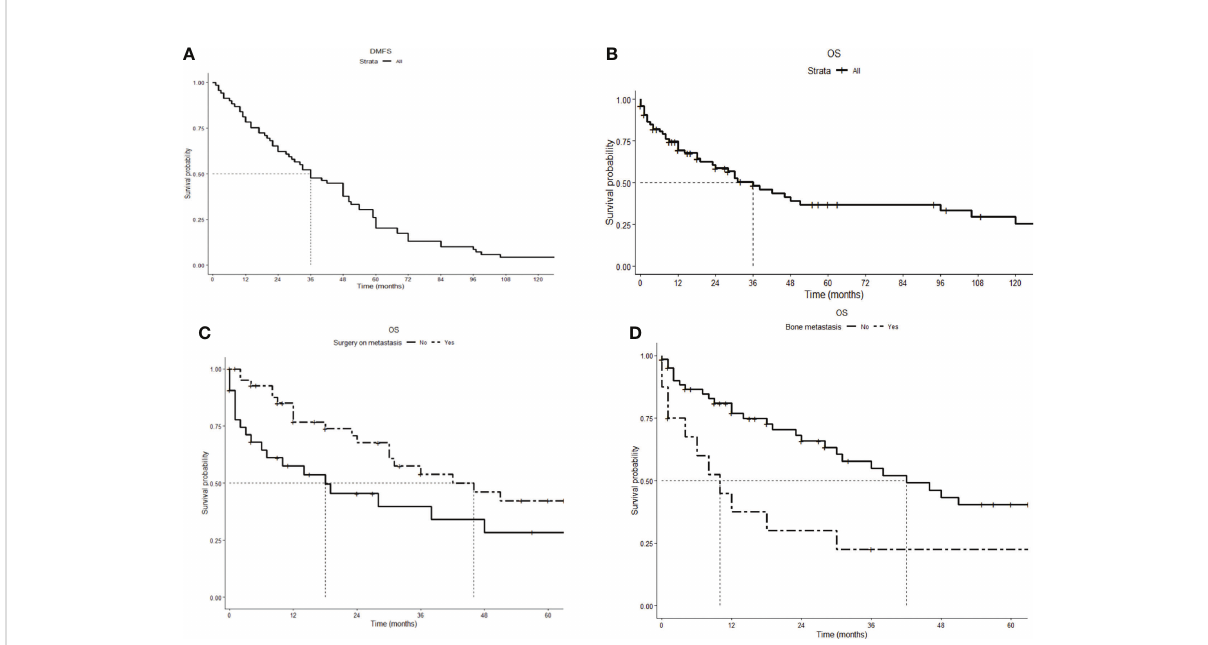
FIGURE 2 Kaplan – Meier survival curves. (A) Distant metastasis-free survival (DMFS): Time from the fi rst diagnosis to diagnosis of metastasis, median 36 (range: 1 – 156) months. (B) Overall survival (OS): time from diagnosis of metastasis to death or last follow-up, median 36 (range: 1 – 252) months. (C) Overall survival comparison for cytoreductive surgery (HR 0.49, 95% CI 0.27 – 0.91). (D) Overall survival comparison for bone metastasis (HR 2.6, 95% CI 1.3 –